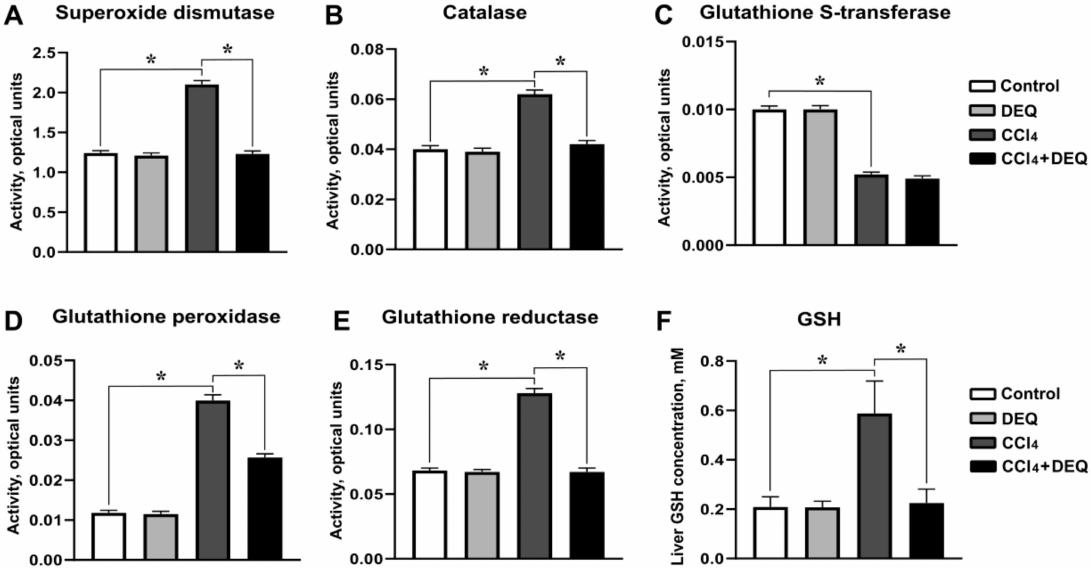
Figure 7. Effect of DEQ administration on liver activities of antioxidant enzymes and reduced glutathione in rats with CCl4-induced liver injury. Treatment of rats with DEQ 3 h after CCl 4 administration every 24 h for 4 days significantly reduced CCl 4 -induced liver activities of superoxide dismutase ( A ), catalase ( B ), glutathione peroxidase ( D ), glutathione reductase ( E ), and reduced glutathione ( F ). The activity of glutathione transferase ( C ) was significantly increased in the liver of animals from CCl 4 group compared to the control group. * p < 0.05. Activity values expressed as enzyme activity per milligram of protein. All data are expressed as mean ±